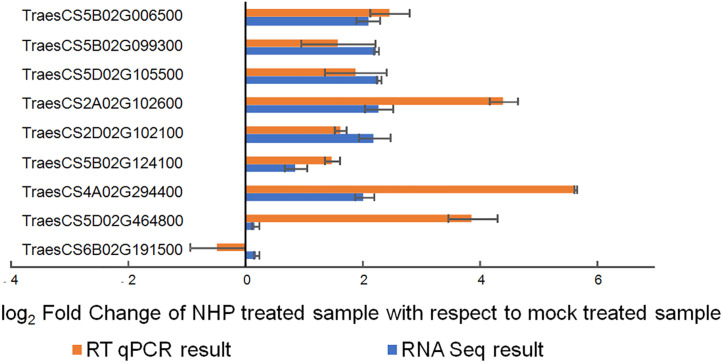
Quantitative real-time reverse transcription quantitative PCR (qRT-PCR) verification of the expression of nine wheat genes upon N-hydroxypipecolic acid (NHP) treatment. Error bars indicate the SE, n = 3.